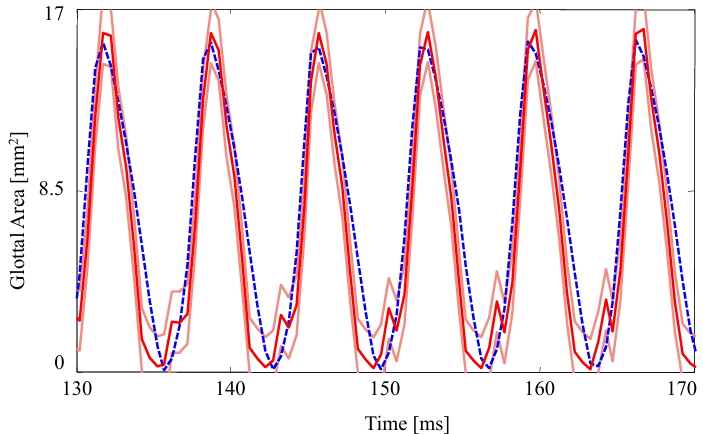
Figure 4. Comparison of the glottal area waveforms extracted from the FE model and the HSV for the case with no medial compression ( p sub = 1kPa). Blue dashed line: HSV; red solid line: FE model; orange solid lines: uncertainty bounds from the FE